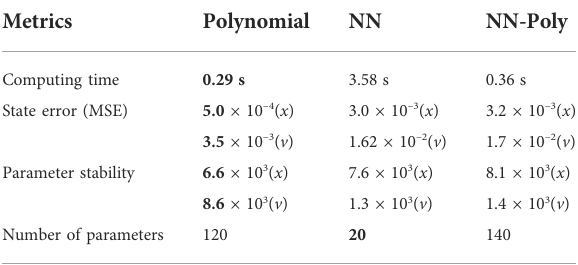
TABLE 5 2 DOF spring pendulum system evaluation of performance for all system identi fi cation methods.